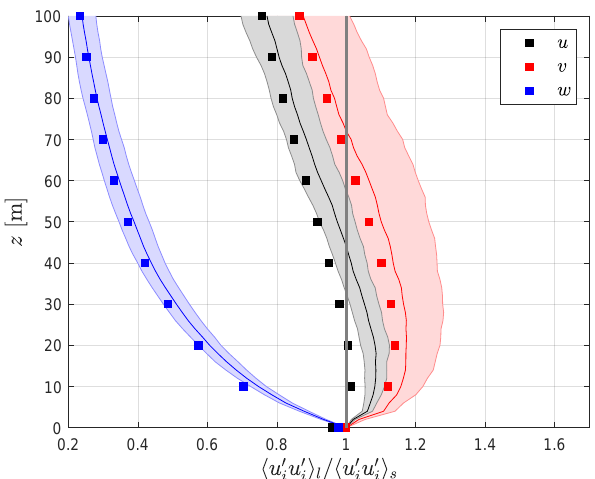
Figure 5. Ratio of the u -, v -, and w -velocity variances measured by a VAD ZX lidar (subscript l ) to that measured by an ideal sonic anemometer (subscript s ) as function of height. Markers correspond to theoretical predictions, and lines and shaded areas are the mean and standard deviation, respectively, of 100 turbulence